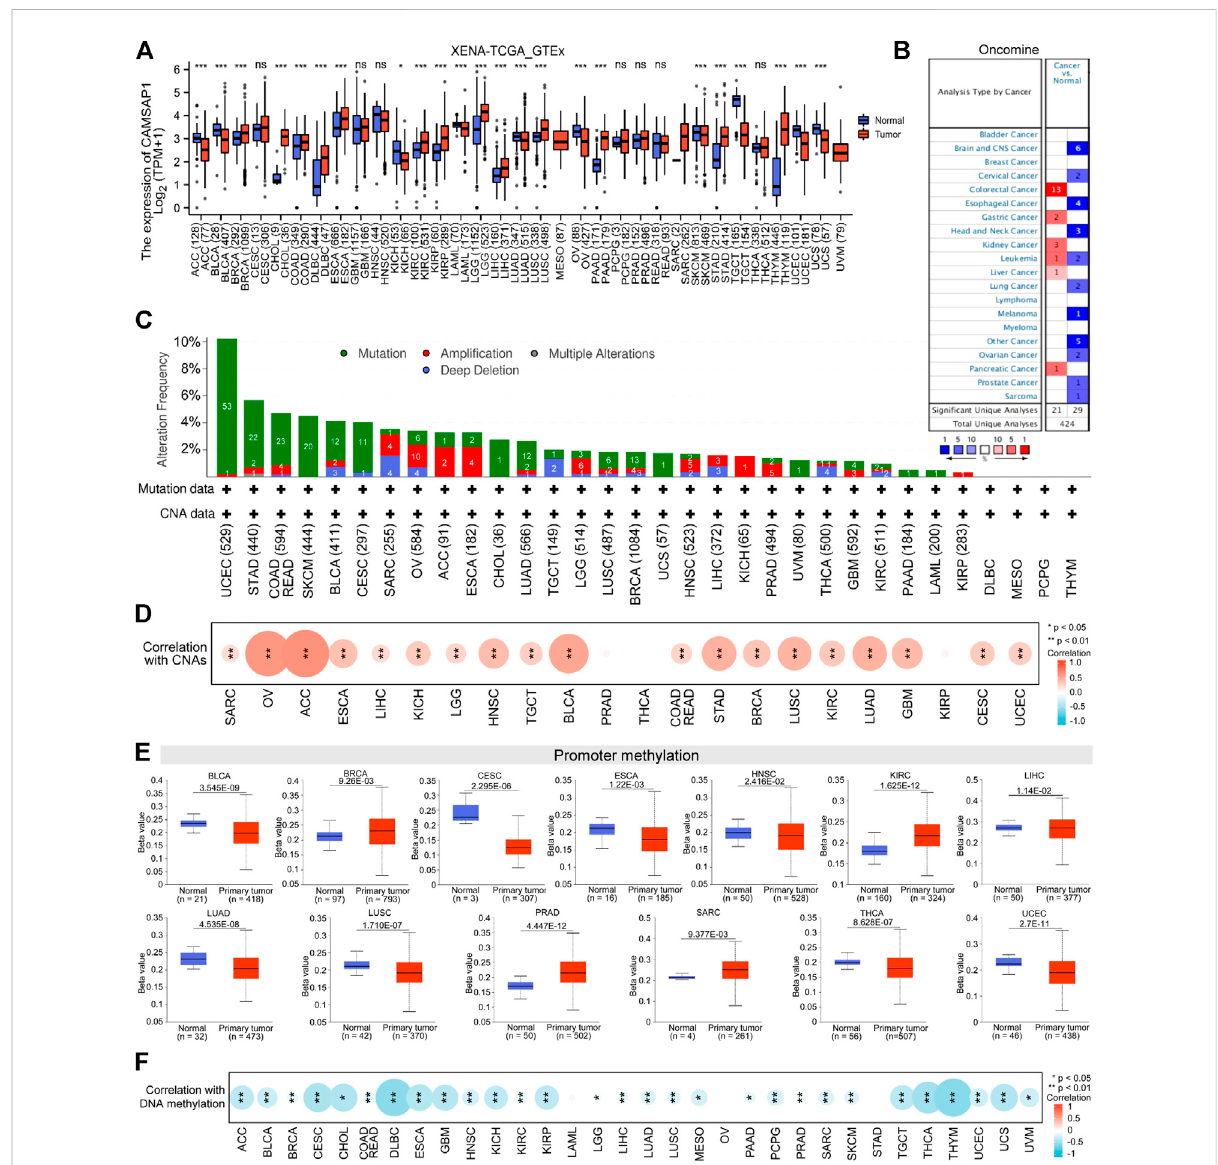
FIGURE 2 Pan-cancerexpressionof CAMSAP1 isassociatedwithgeneticalterationandDNAmethylation. (A) Theexpressionof CAMSAP1 innormalversus 33typesoftumor tissues from UCSC Xena database. ns: p ≥ 0.05, * p < 0.05, ** p < 0.01, *** p < 0.001. ACC, adrenocortical carcinoma; BLCA, bladder urothelial carcinoma; BRCA, breast in fi ltrating carcinoma; CESC, cervical squamous cell carcinoma and endocervical adenocarcinoma; CHOL, cholangiocarcinoma; COAD, colon adenocarcinoma; DLBC, diffuse large B cell lymphoma; ESCA, esophageal carcinoma; GBM, glioblastoma multiforme;HNSC,headandnecksquamouscellcarcinoma,KICH,kidneychromophobe;KIRC,kidneyrenalclearcellcarcinoma;KIRP,kidneyrenal papillary cell carcinoma; LAML, acute myeloid leukemia; LGG, brain low-grade glioma; LIHC, liver hepatocellular carcinoma; LUAD, lung adenocarcinoma; LUSC, lung squamous cell carcinoma; MESO, mesothelioma; OV, ovarian serous cystadenocarcinoma; PAAD, pancreatic adenocarcinoma; PCPG, pheochromocytoma and paraganglioma; PRAD, prostate adenocarcinoma; READ, rectum adenocarcinoma; SARC, sarcoma; SKCM, skin cutaneous melanoma; STAD, stomach adenocarcinoma; TGCT, testicular germ cell tumors; THCA, thyroid carcinoma; THYM, thymoma; UCEC, uterine corpus endometrial carcinoma; UCS, uterine carcinosarcoma; UVM, uveal melanoma. (B) The expression of CAMSAP1 from the Oncomine portal. Red represented high expression in cancer, blue represented low expression in cancer, and the number in the table representeddatasetsthatmeetthethreshold.Thethresholdwas p < 0.0001,foldchange > 1.5andgenerank=10%. (C,D) CAMSAP1 geneticvariation (C) and itscorrelation with CNAs (D) in pan-cancer fromcBioPortal. (E) CAMSAP1 promoter methylation innormal and primary tumor fromUALCAN portal. (F) Correlation between CAMSAP1 and DNA methylation from cBioPortal. * p < 0.05, ** p <